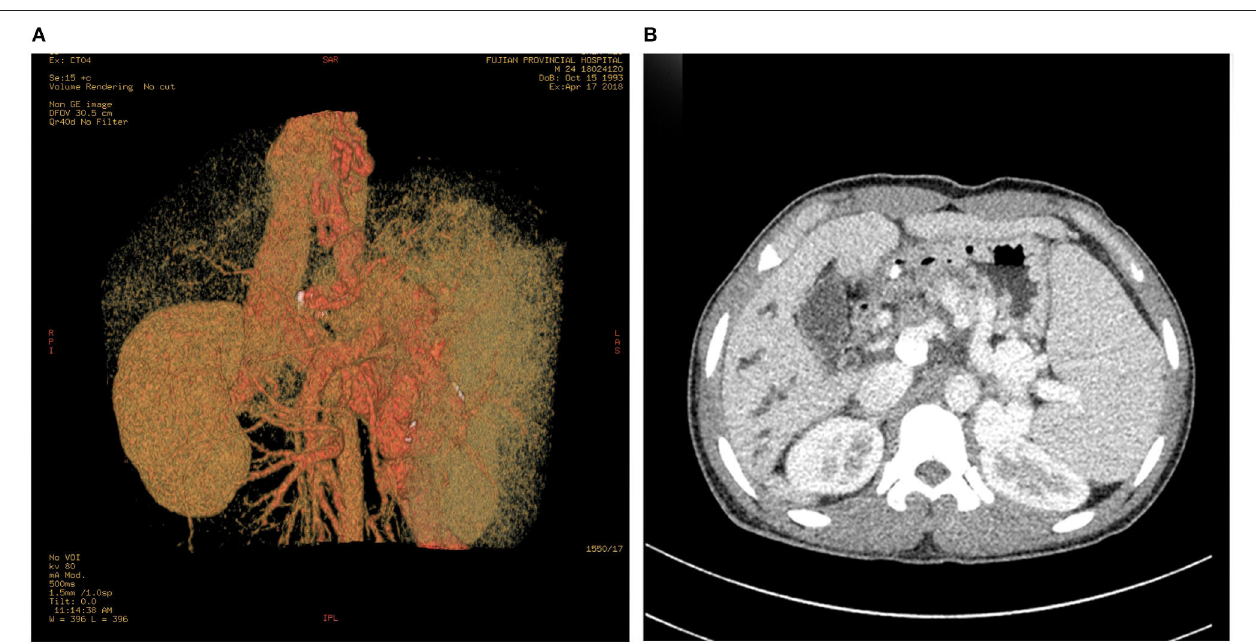
FIGURE 3 | PV-CTA shows that one branch of SV flows into IVC via LRV (A) . The other branch of SV merges with SMV into PV, the intrahepatic branch of PV is slim, and the proximal trunk of PV is short and calcified (B) . The esophageal and gastric fundus vein (A) , and the SV are dilated and tortuous (B) . Dilatation of intrahepatic bile duct (B) . PV-CTA, portal vein-computed tomographic angiography; SV, splenic vein; IVC, Inferior vena cava; LRV, left renal vein; SMV, superior mesenteric